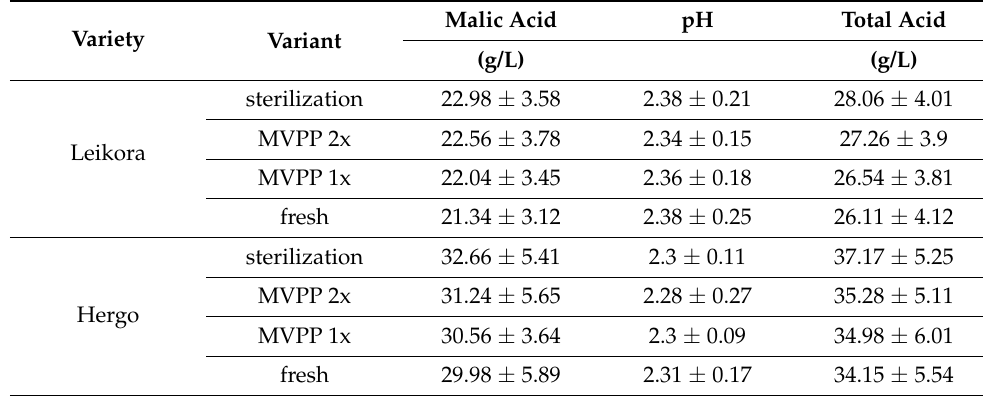
Table 2. Malic acid, pH level, and total acid content change during thermal treatment variants and their statistical